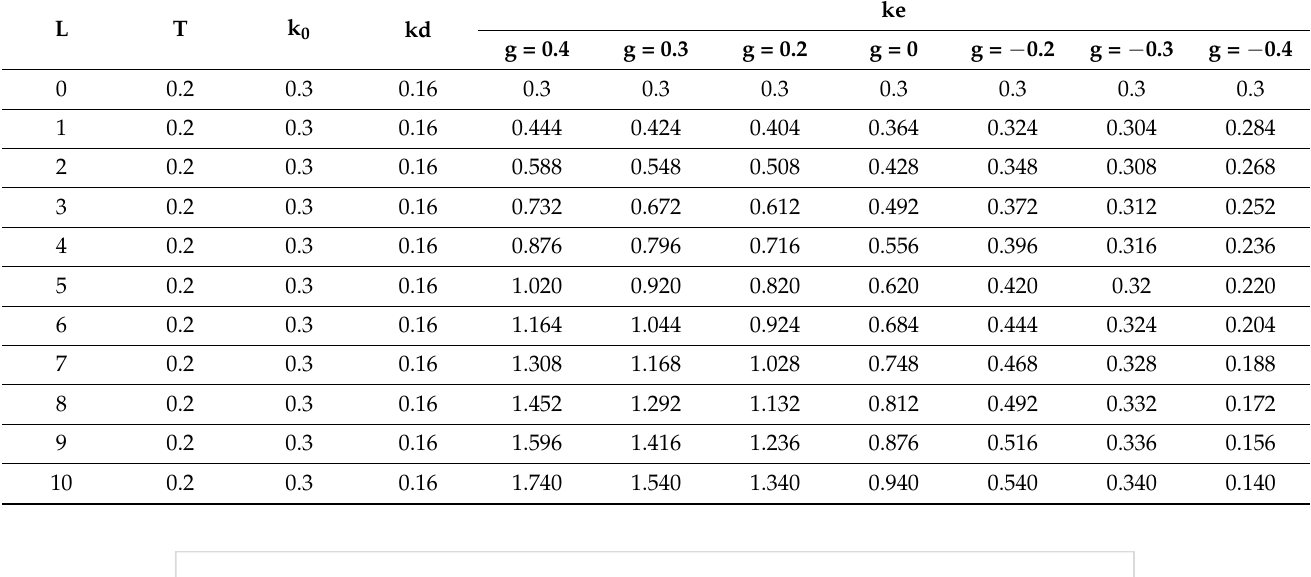
Table 8. Dependence of equity cost k e on leverage level L in Generalized Modigliani–Miller theory (GMM theory) at